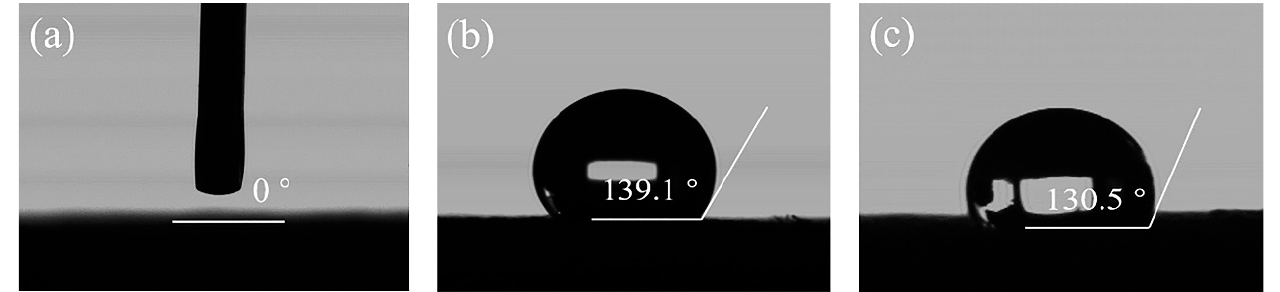
Figure 2. SEM and EDS images of ceramic membrane: ( a , b ) SEM of unmodi fi ed ceramic membrane; ( c , d ) SEM of PDMS-ceramic membrane; ( e ) SEM of PTFE-ceramic membrane; and ( f ) EDS mapping of PTFE-ceramic membrane.